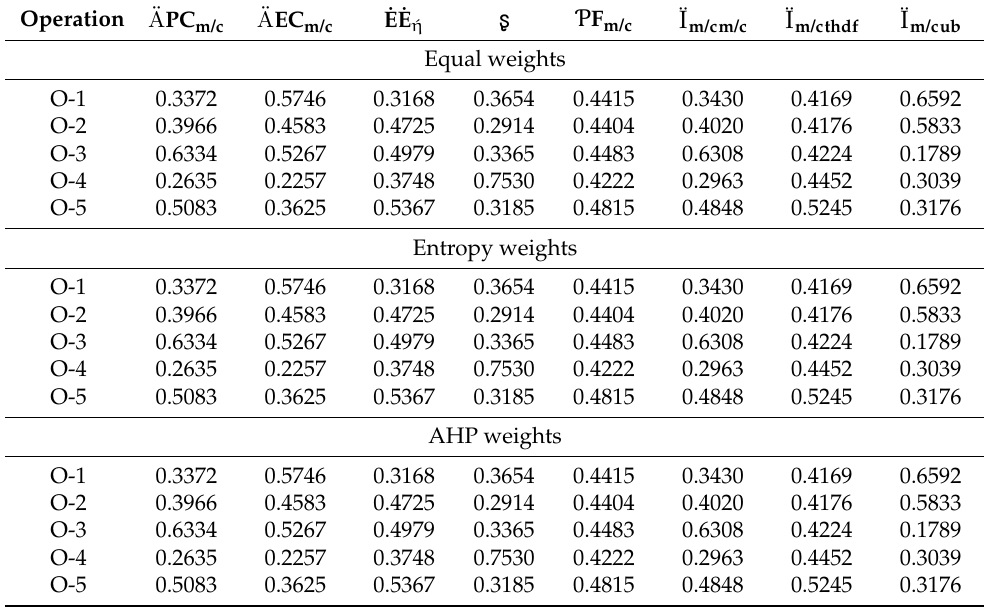
Table A3. Normalized decision matrix